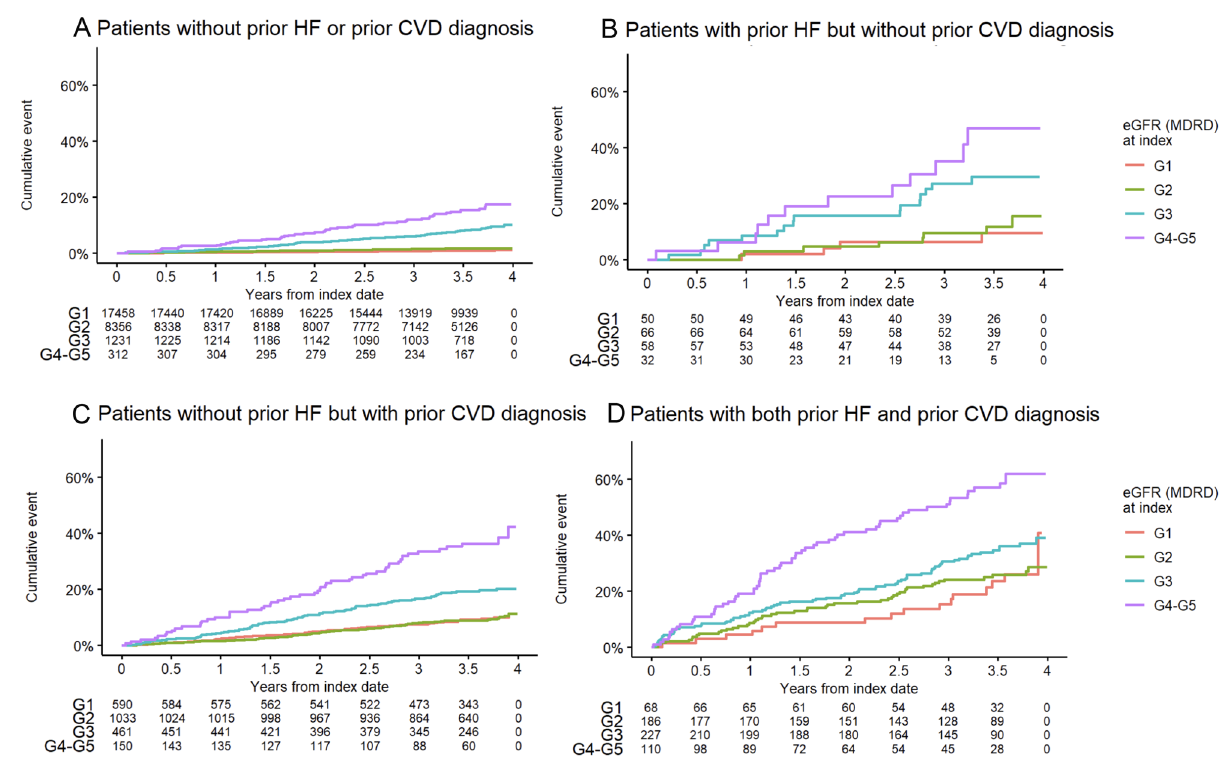
Figure 1. ( A )–( D ) Mortality according to previous history of CVD, heart failure and eGFR stages.